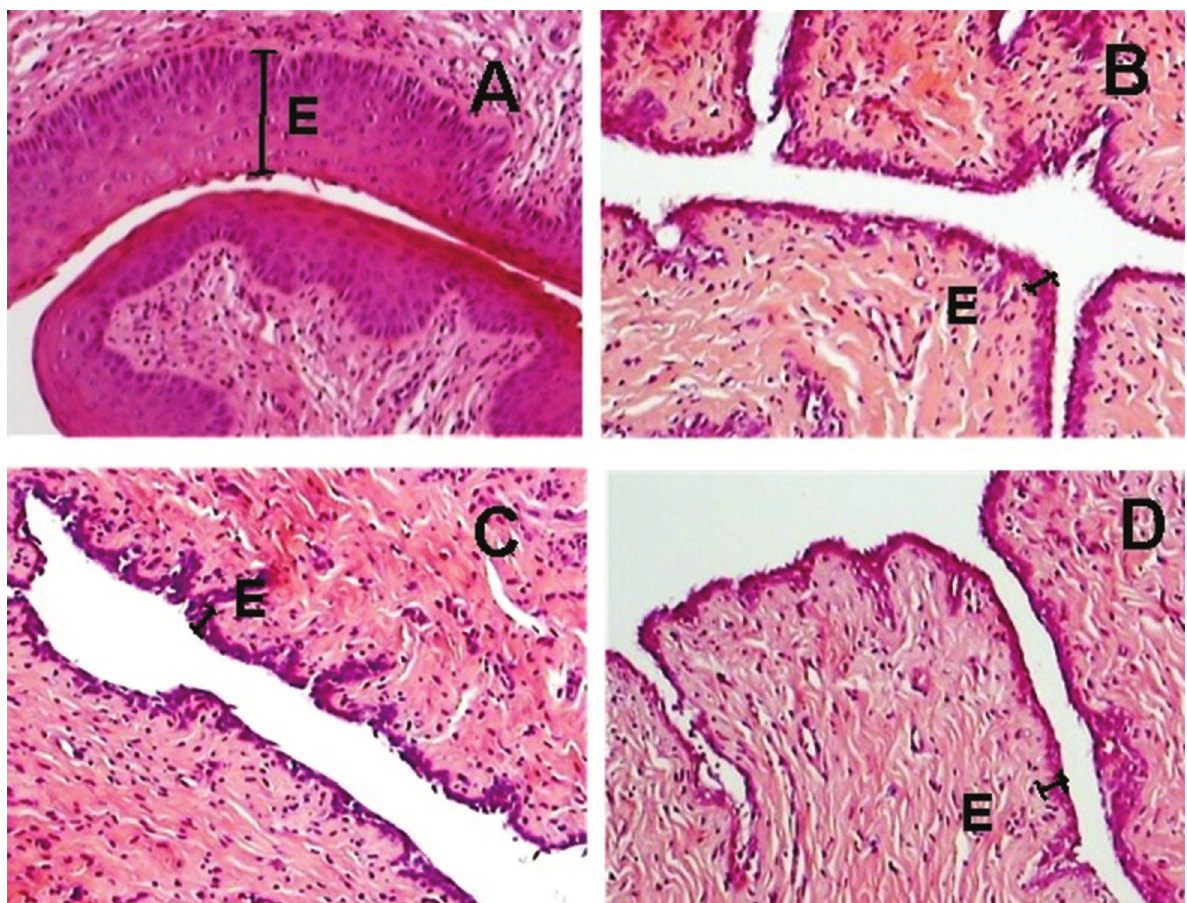
Figure 1 - Photomicrographs of histological sections of the vaginal epithelium of rats. Note the thickness of the vaginal epithelium (E) and keratin in rats in persistent estrus (A) and the thin layer of basal and parabasal cells in the castrated rats of Groups II (vehicle) (B), III (5% pilocarpine) (C) and IV (15% pilocarpine) (D). Original magnification 100x.